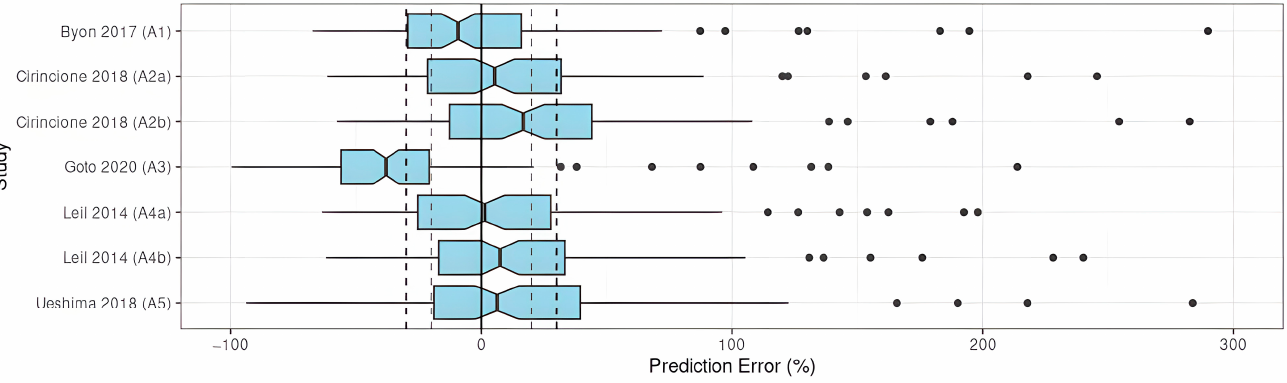
Figure 2. PE% of apixaban population pharmacokinetic studies applied to the external validation dataset [22–26]. dataset